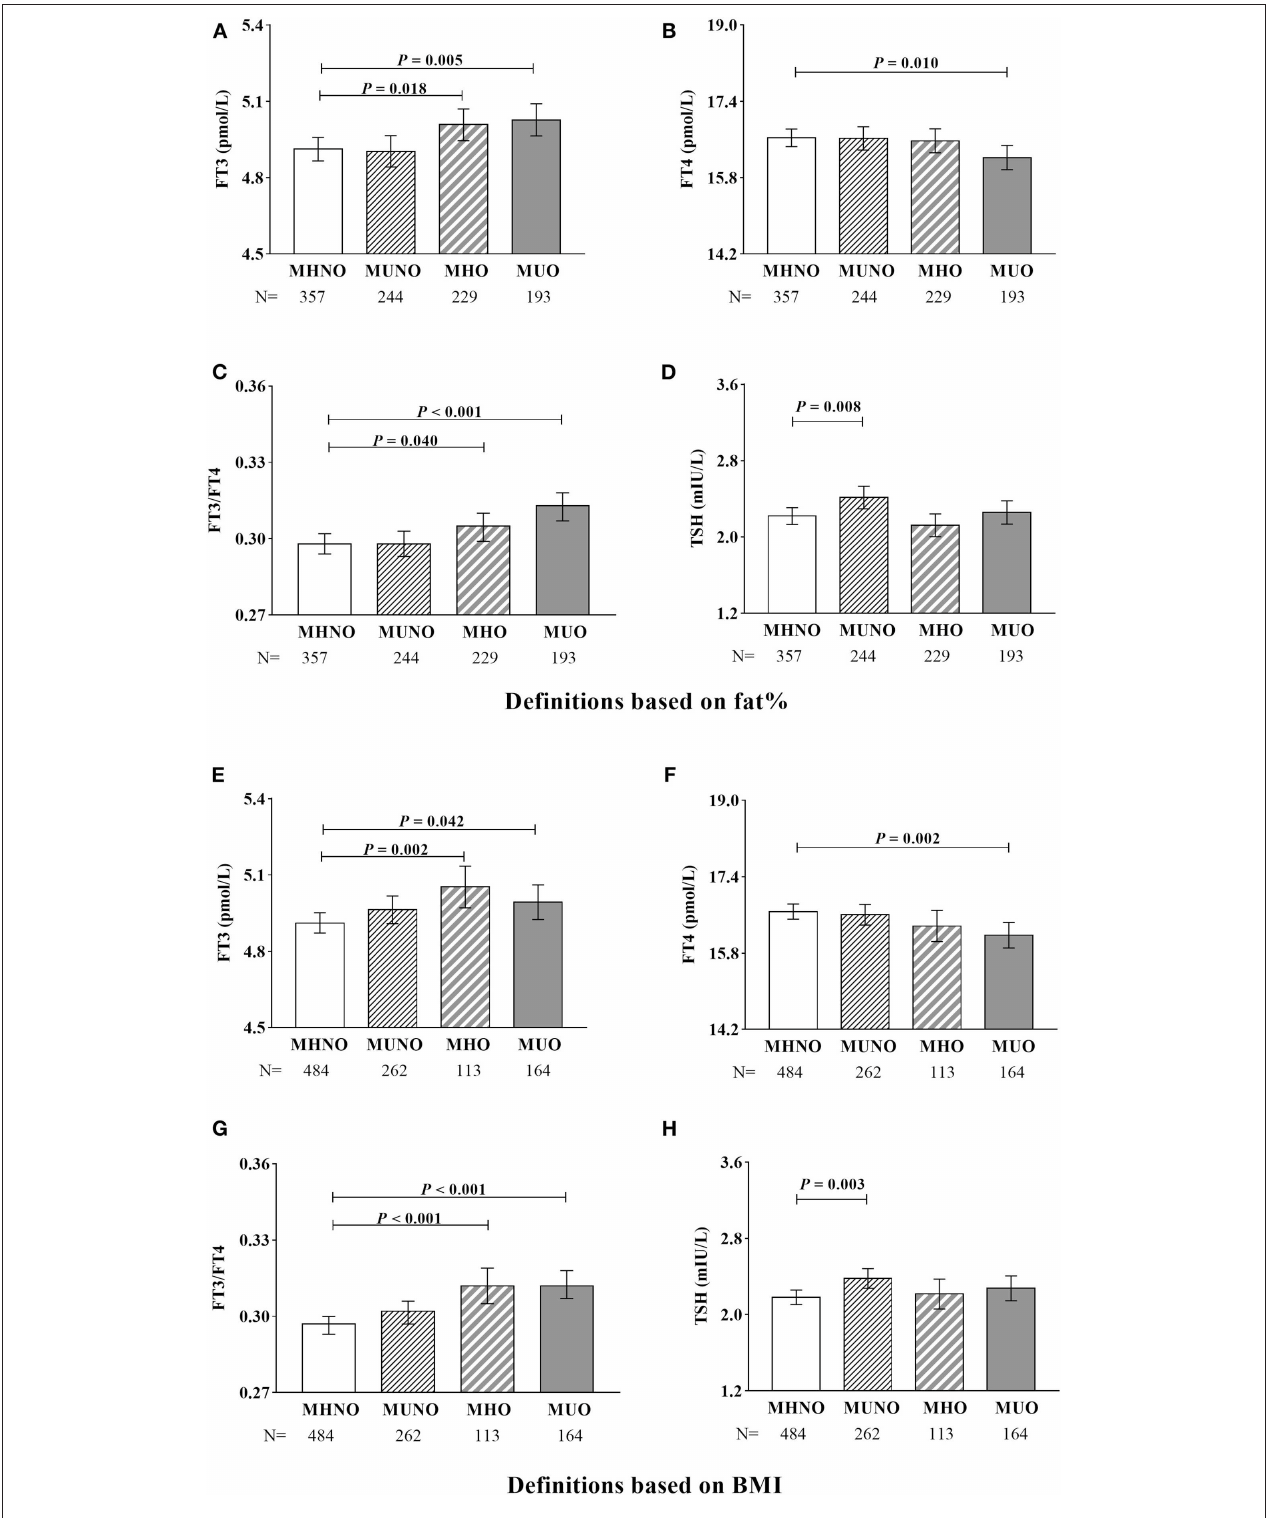
FIGURE 2 | Covariance analysis of thyroid hormones in different metabolic phenotypes of obesity. (A–D) Definitions based on fat%. (E–H) Definitions based on BMI. Age and gender were adjusted. In the graph, the column indicated to adjusted mean, the bars indicated to 95% confidence interval.